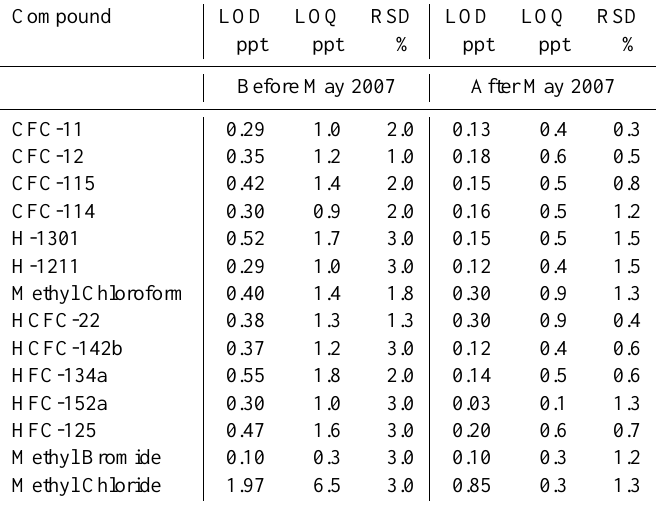
Table 1. Limits of detection (LOD), limits of quantification (LOQ), and percent relative standard deviation (RSD %) calculated on 25 repeated measurements of a reference mixture containing the compounds considered in this study, before and after the instrument upgrading (May 2007). Compound LOD LOQ RSD LOD LOQ RSD ppt ppt %